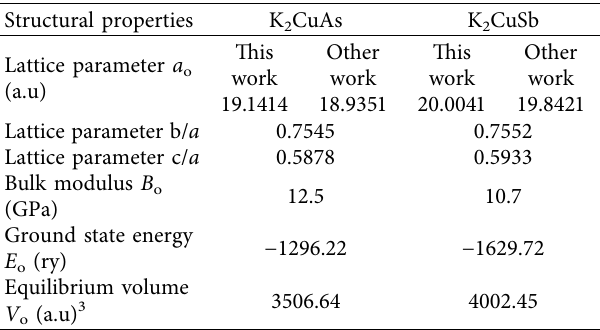
2 CuAs and K 2 CuSb ternary